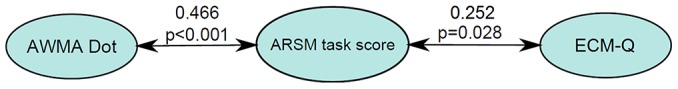
Correlations found between the ARSM task score and traditional tests.